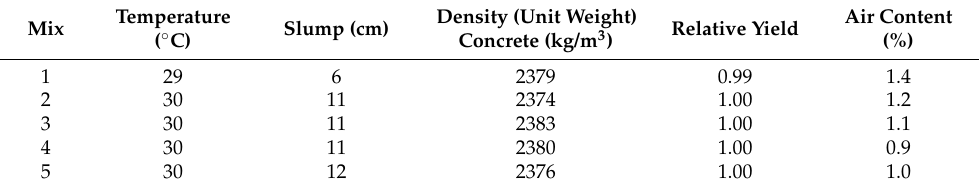
Table 8. Results of concrete characteristics in the fresh